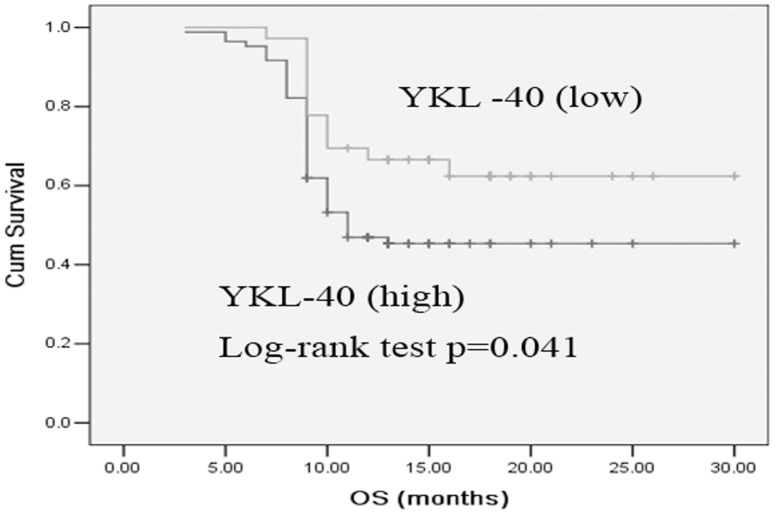
Kaplan-Meier curve comparing OS of SCLC patients with high serum YKL-40 versus those with low serum YKL-40.The Log-rank test showed that the survival times were significantly longer in patients with low serum YKL-40 than those of high serum YKL-40 (p = 0.041).